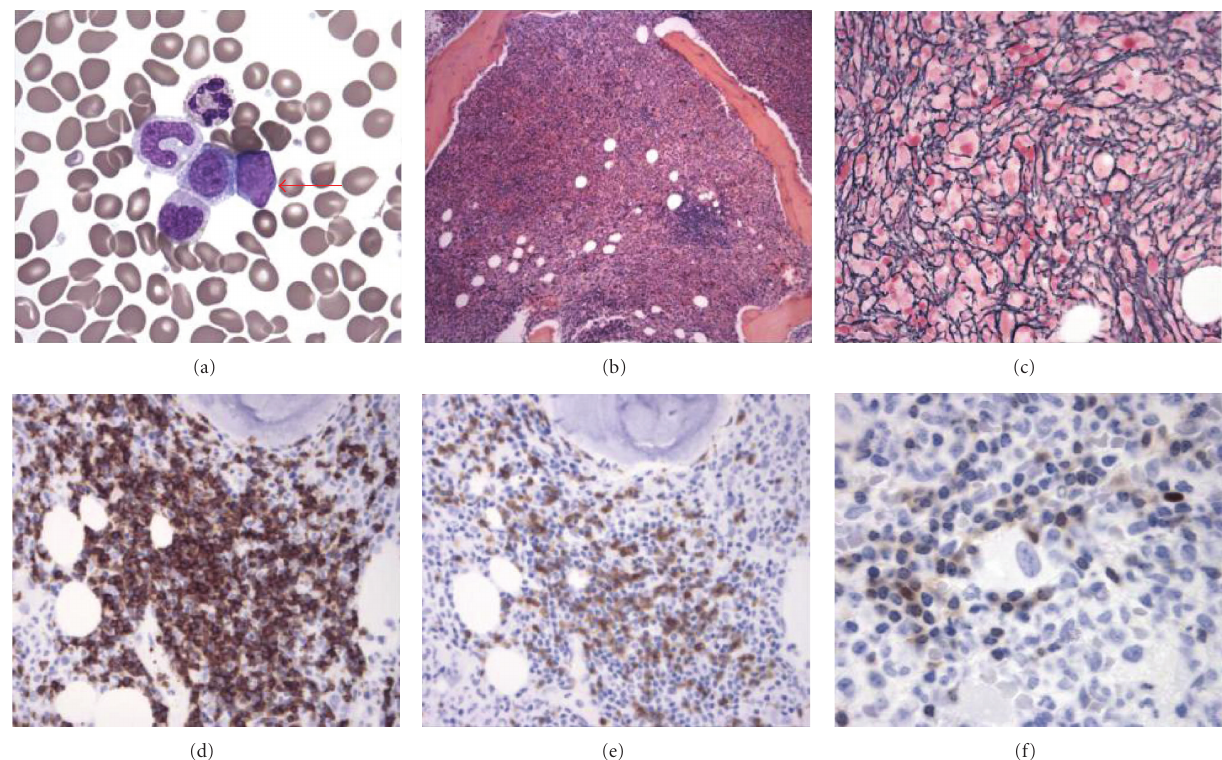
Figure 2: Primary myelofibrosis, fibrotic stage: (a) peripheral blood smear, Wright-Giemsa stain, blast (arrow), Ob. 100x immersion oil. (b) Hypercellular bone marrow biopsy, Hematoxylin and eosin stain, Ob. 50x (c) bone marrow biopsy with markedly increased reticulin deposition. Ob. 50x, (d) Anti-CD20 antibody highlights a large subset of positive lymphoid cells in a lymphoid aggregate, Ob. 50x. (e) Anti- CD3 antibody highlights a small subset of CD3+ T-cells in a lymphoid aggregate, Ob. 50x. (f) Anti-Cyclin D1 antibody highlights a small subset of positive nuclei in a lymphoid aggregate, Ob.